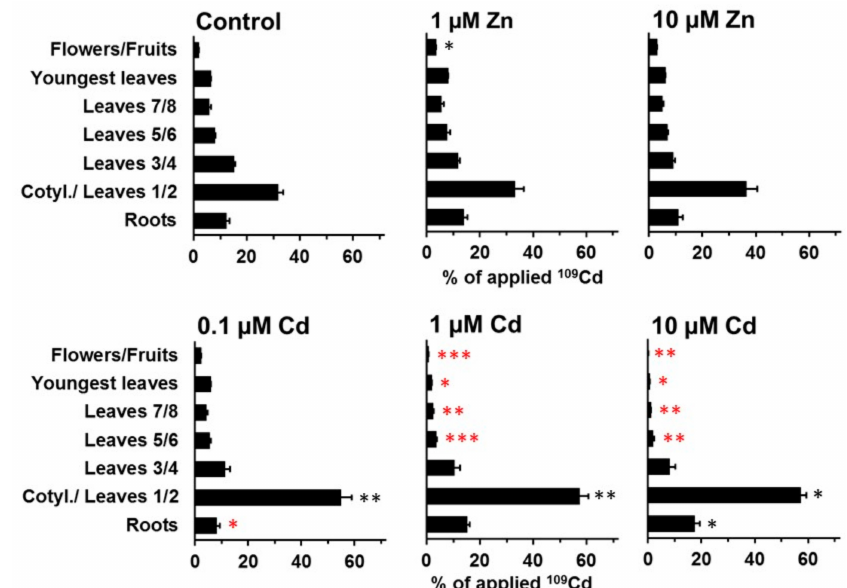
Figure 7. Redistribution of 109 Cd in plants grown on standard nutrient medium (Control) or on the same medium with increased Zn (1 µ M Zn and 10 µ M Zn) or Cd (0.1 µ M Cd, 1 µ M Cd, and 10 µ M Cd) concentrations for 21 d after the labeling phase (duration: 3 d). Means + SE of four replicates are shown. Significantly higher (*, **, ***) and lower (*, **, ***) values than in control plants on the P = 0.05 (*, *), P = 0.01 (**, **), and P = 0.001 (***, ***) level are indicated (Student’s t-test).